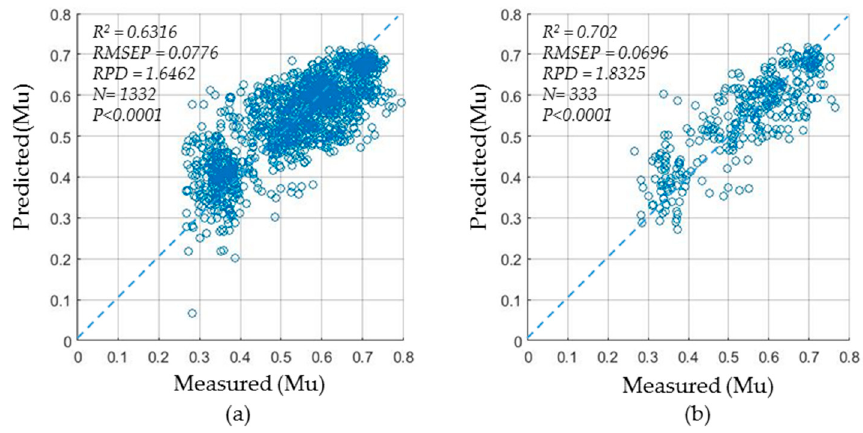
Figure 4. Model performance results: ( a ) Measured vs. predicted friction values for full cross-validation; ( b ) Measured vs. predicted values for internal validation.